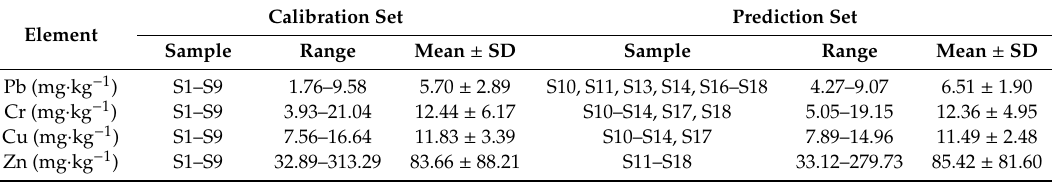
Table 1. Statistics results of prepared standard